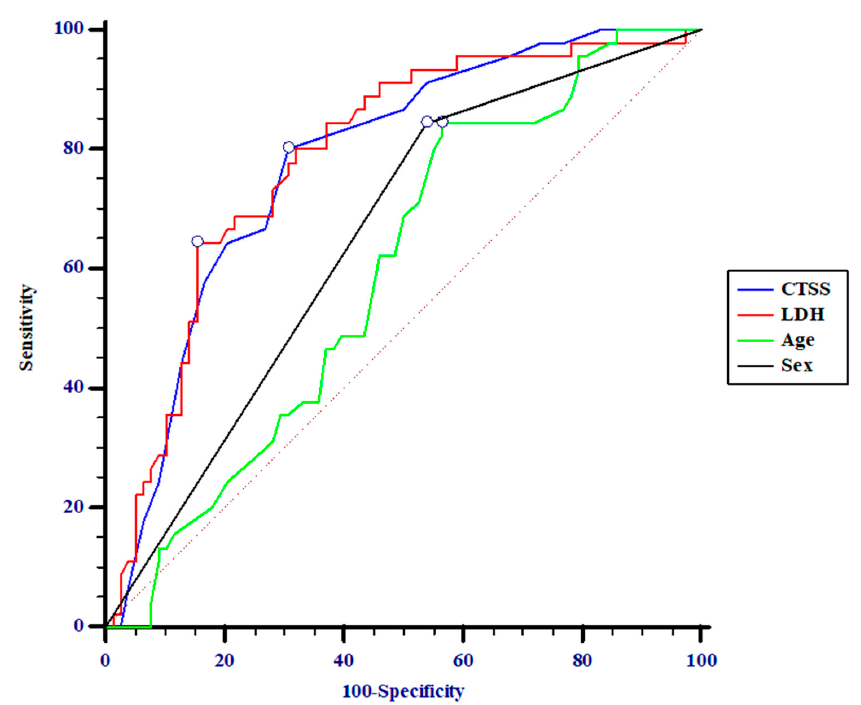
Figure 1. Comparison of ROC curves: CTSS–age, p = 0.0023; CTSS–gender, p = 0.0394; LDH–age, p = 0.0026; LDH–gender, p = 0.0360; age–gender, p = 0.3710; CTSS–LDH, p =